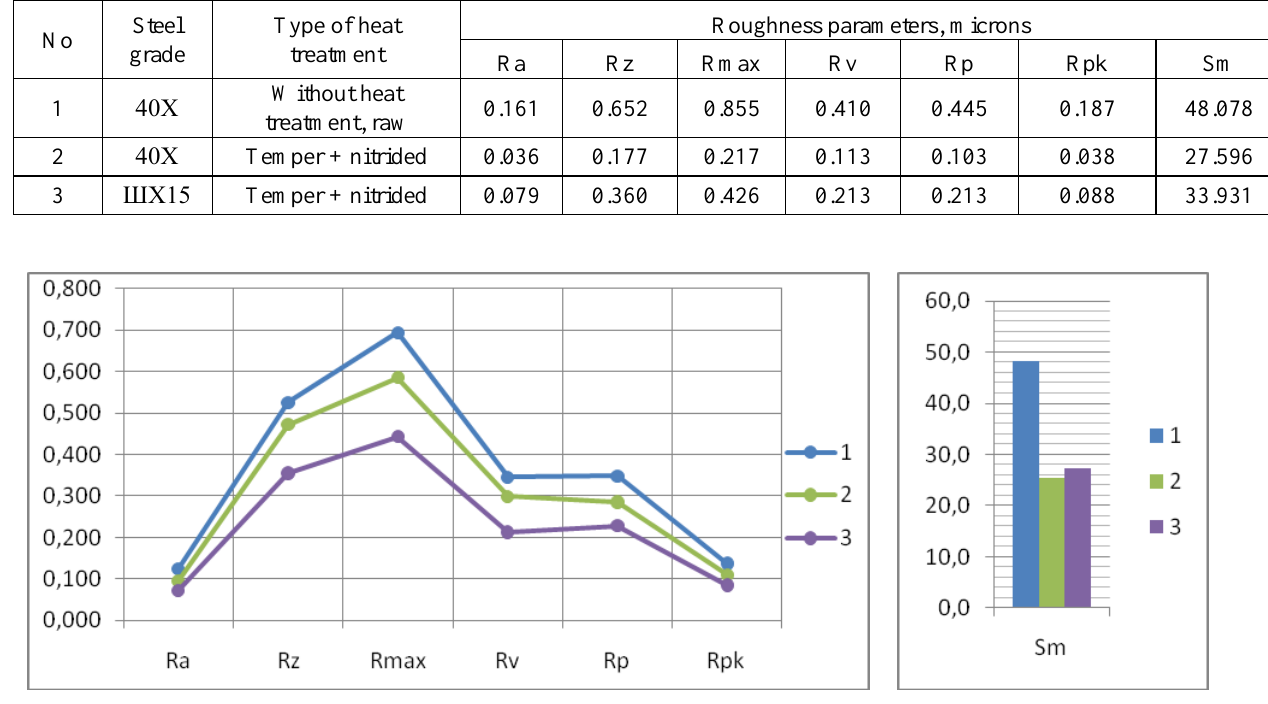
Parameters of the investigated roughness along the lateral